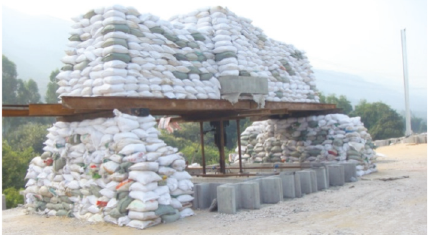
Figure 3: Test site of the field cyclic loading